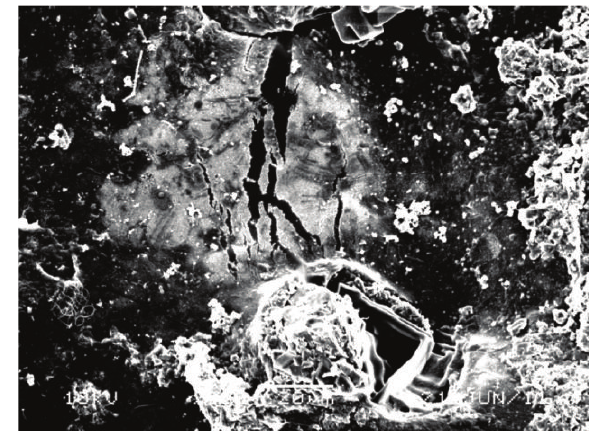
Figure 7: SEM image of vinylester resin with details of the blistering caused by a 32-day immersion in